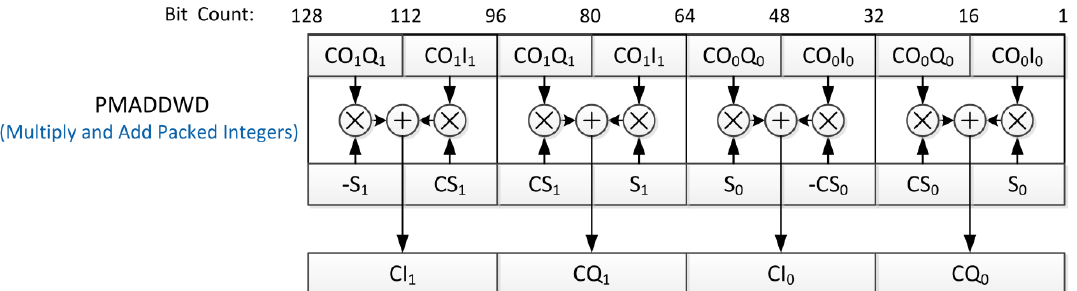
Figure 7. Complex data format for executing PMADDWD instruction and operations inside